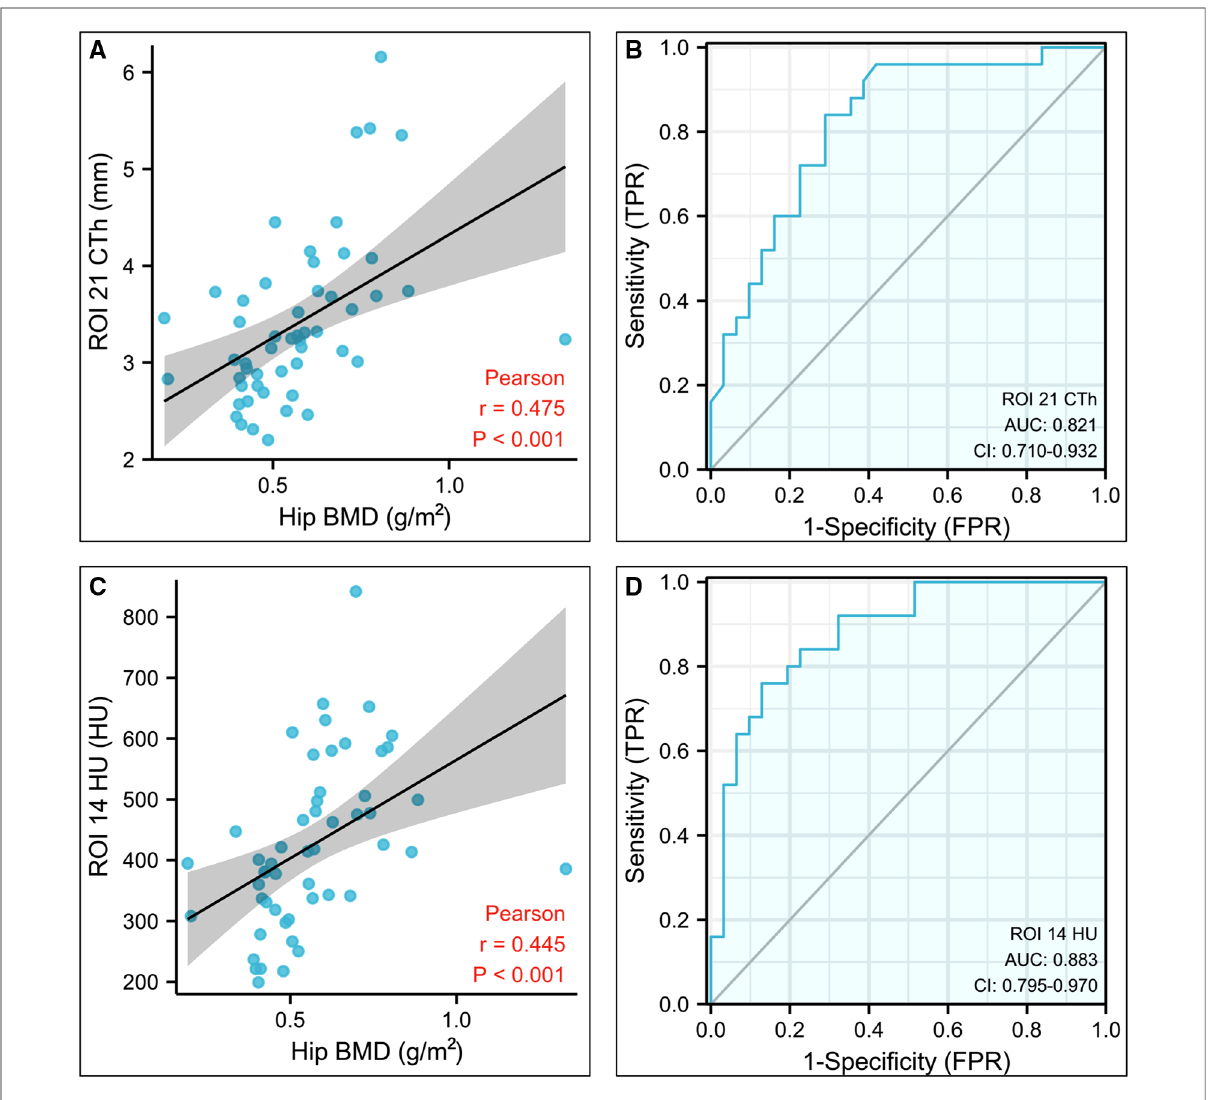
FIGURE 4 Statistical analysis results of the CTh value of the region of interest (ROI) 21 and HU value of the ROI 14. ( A ) Plot illustrating the correlation between the CTh value of ROI 21 and hip bone mineral density. ( B ) Diagnostic ef fi ciency of the CTh value of ROI 21 for osteoporosis. ( C ) Plot illustrating the correlation between the HU value of ROI 14 and hip bone mineral density. ( D ) Diagnostic ef fi ciency of the HU value of ROI 14 for osteoporosis. CTh, cortical bone thickness; HU, Houns fi eld unit; ROI, region of interest.